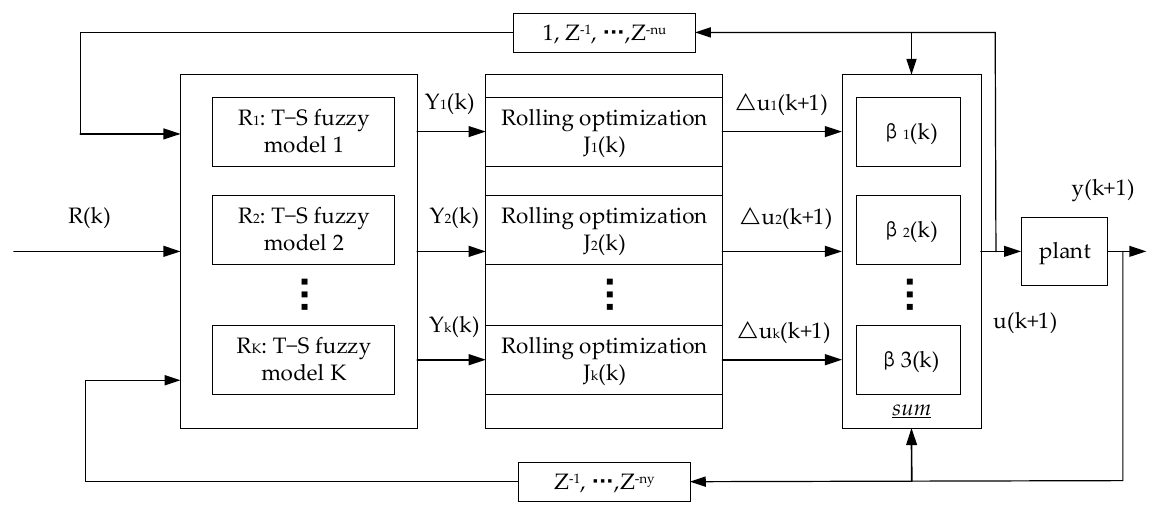
Figure 7. Proposed Disturbance Observer.